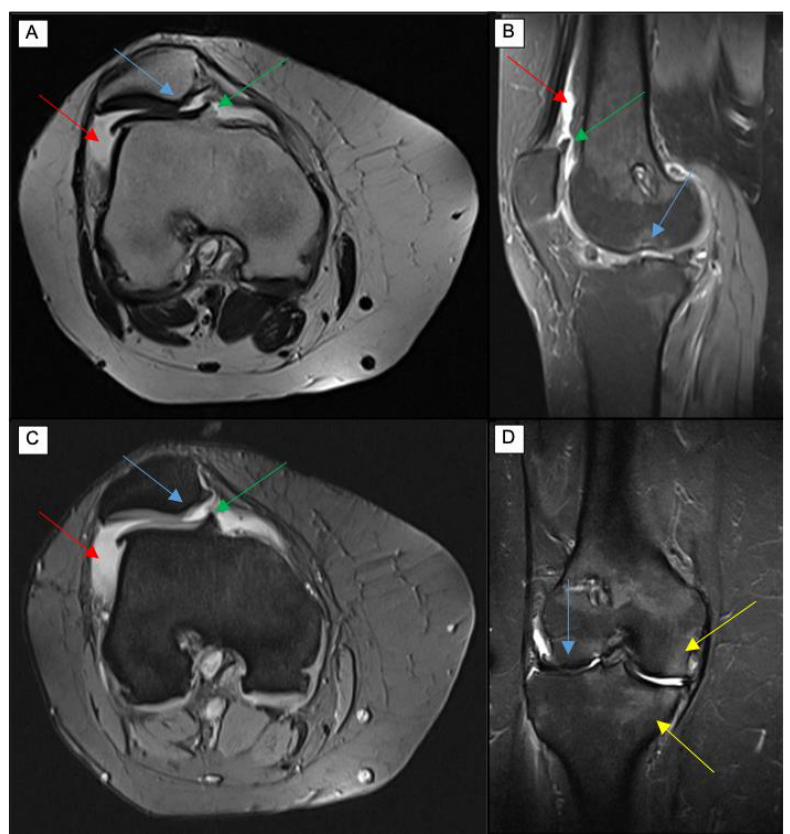
Figure 1. Axial T2 ( A ) and GRE ( C ), sagittal PD ( B ), and coronal STIR ( D ) MRI sequences showing features of severe knee osteoarthritis, including femoropatellar and femorotibial cartilage damage (blue arrows), effusion with synovitis (red arrows), marginal osteophytosis (green arrows), and subchondral bone marrow edema (yellow arrows).